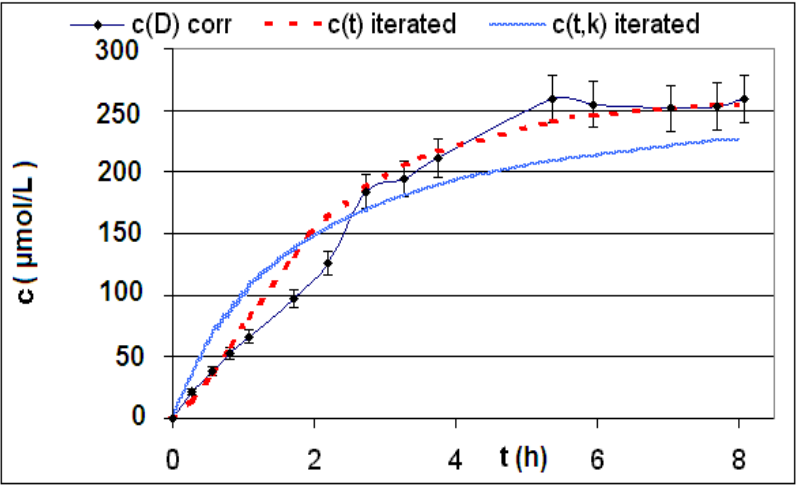
( t ) /c ( t ) /c ( t,k ) only for product P. corr iterated iterated